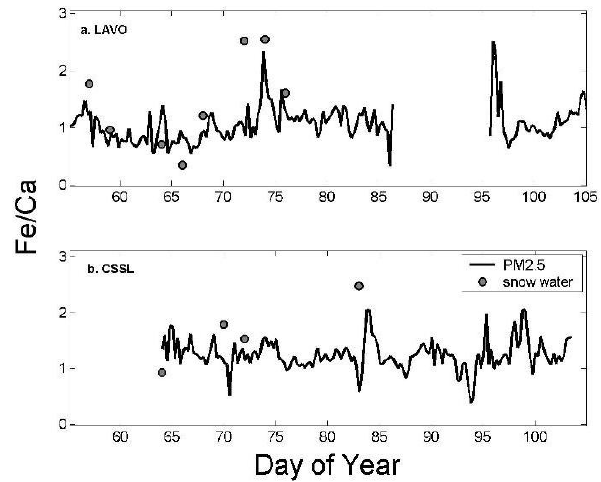
Fig. 4. Fe/Ca ratios in PM 2.5 ambient particulate matter and in the snow water, at (a) LAVO and (b)